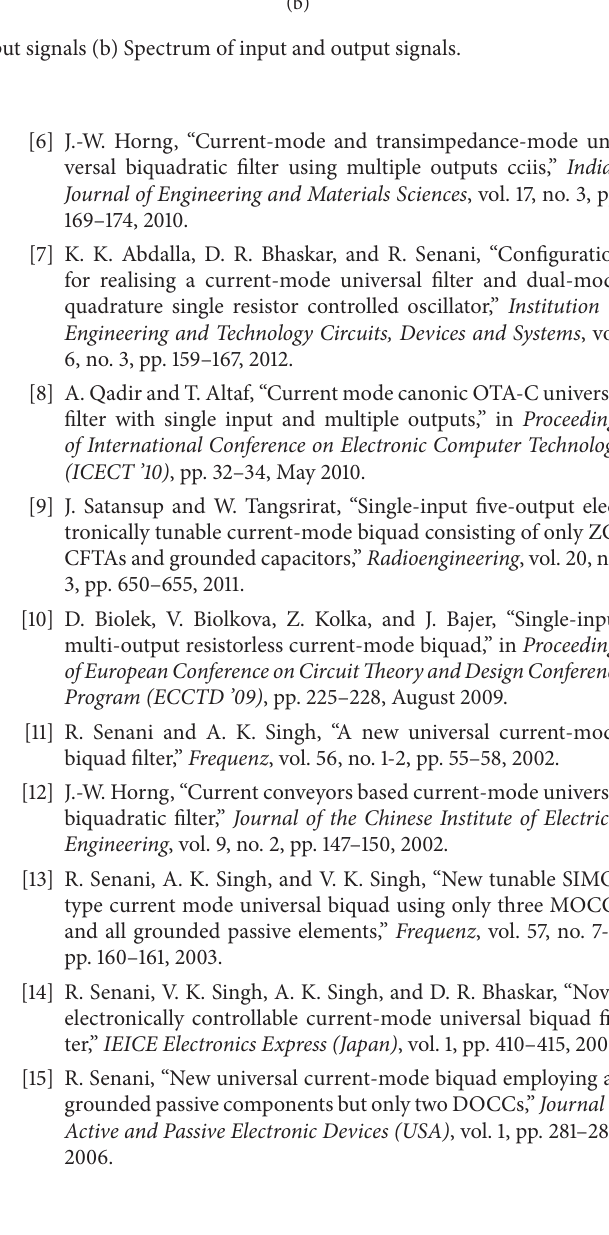
Figure 12: (a) Transient response of input and output signals (b) Spectrum of input and output signals.